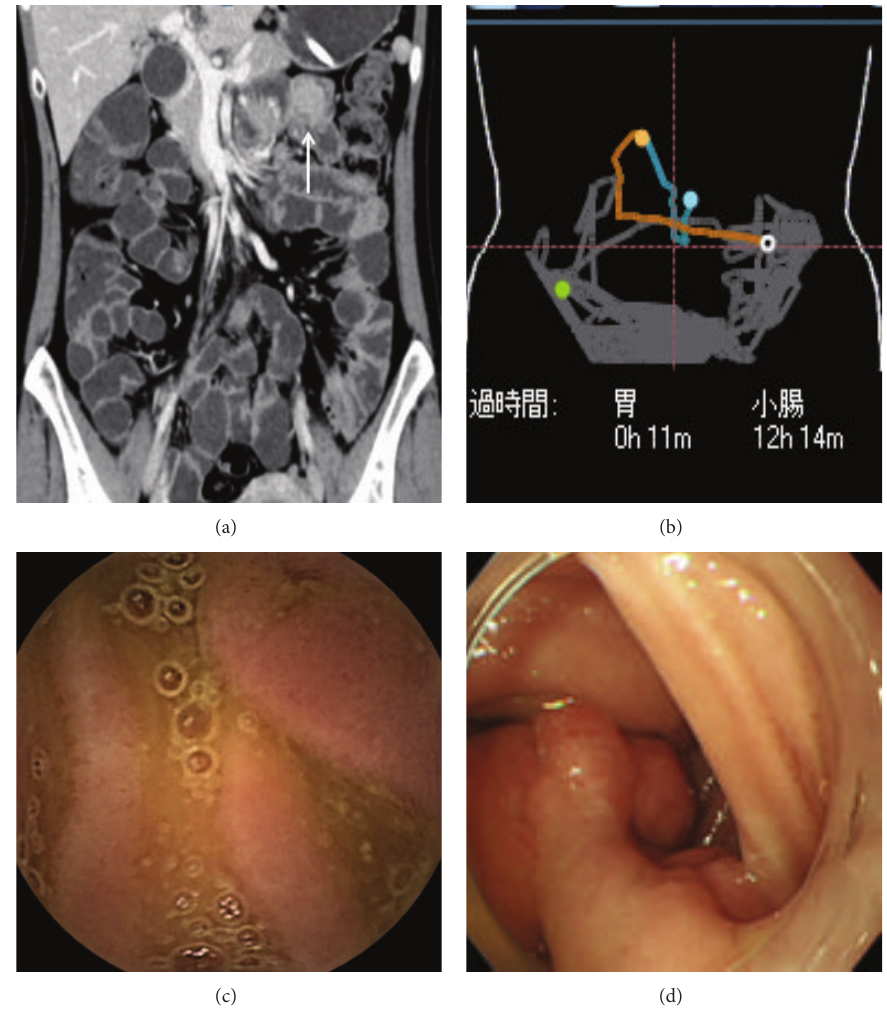
Figure 2: Findings from computed tomography enteroclysis/enterography (CTE), capsule endoscopy (CE), and balloon endoscopy (BE). (a) Strongly stained tumorous lesions in the small intestine detected by CTE; (b) the trajectory of CE in the vicinity of the area where CTE detected the lesions; (c) CE findings in the vicinity where lesions are detected by CTE. No lesion was detected by CE; (d) BE is performed after CE, and polypoid lesion was confirmed in the vicinity of the lesion detected by